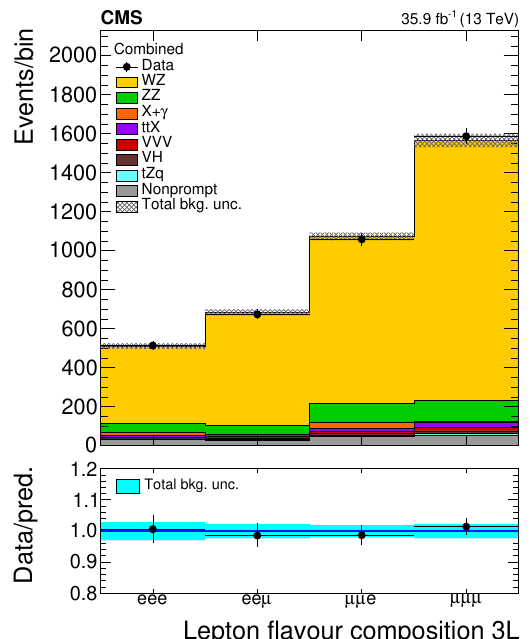
Figure 6 . Distribution of expected and observed event yields in the four (cid:13)avour categories used for the cross section measurement. Vertical bars on the data points include the statistical uncertainty and shaded bands over the prediction include the contributions of the di(cid:11)erent sources of uncertainty evaluated after the signal extraction